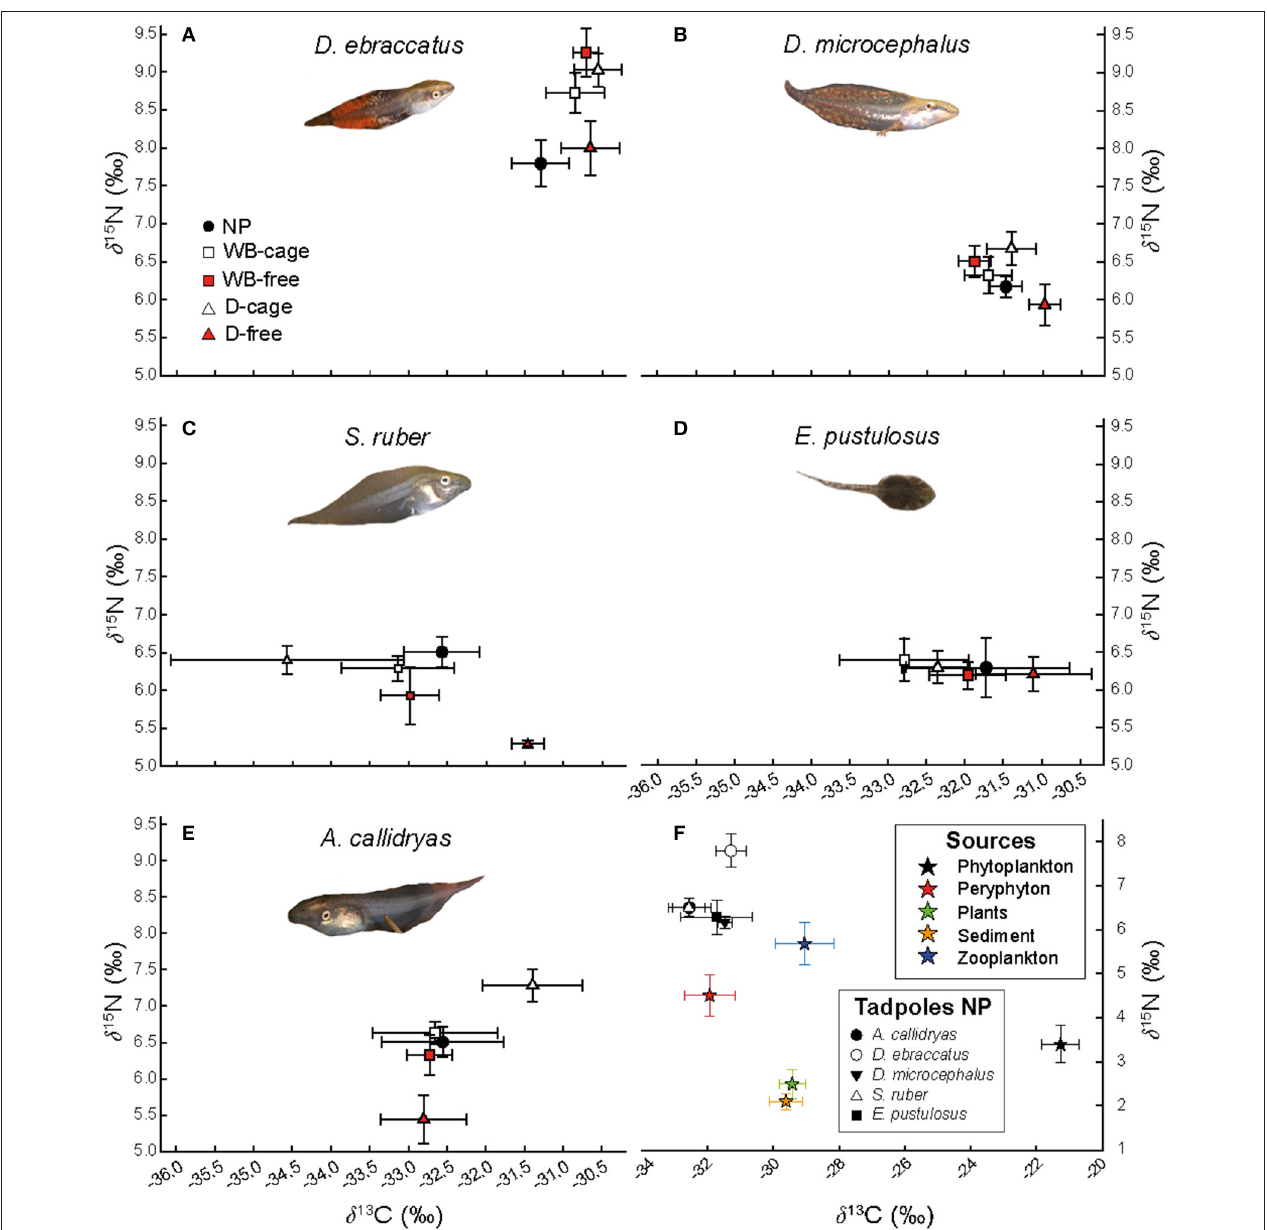
FIGURE 5 | Biplot of stable isotopic values ( δ 13 C and δ 15 N, mean ± SE) for each tadpole species included in the mesocosms: (A) D. ebraccatus ; (B) D. microcephalus ; (C) S. ruber; (D) E. pustulosus; (E) A. callidryas . (F) Represents the isotopic values of potential food sources in the mesocosms (mean ± SE) and the isotopic values of the five amphibian species in a predator-free environment (NP). δ 13 C and δ 15 N values are represented in the absence of predators (NP, black circles) and in each of the four treatments with predators [treatments with water bugs (WB) are represented with squares and dragonflies (D) are represented with triangles, whereas white or red color indicate caged and uncaged predators